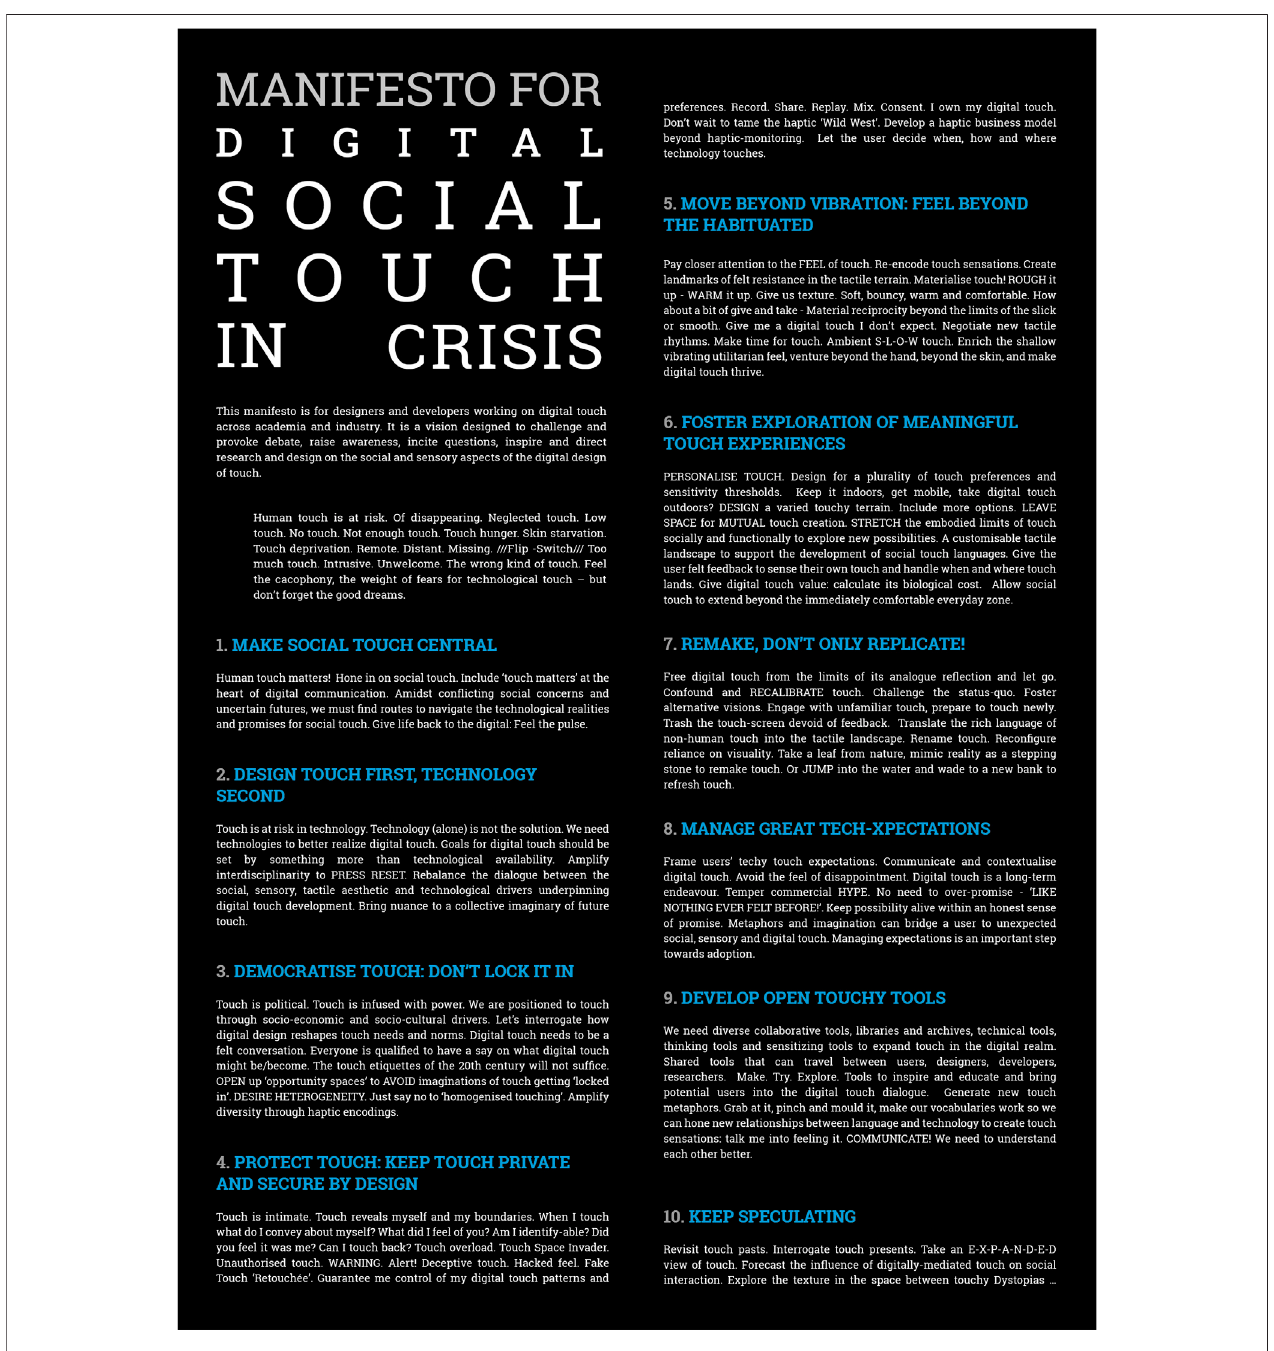
FIGURE 1 | A Manifesto for digital social touch in